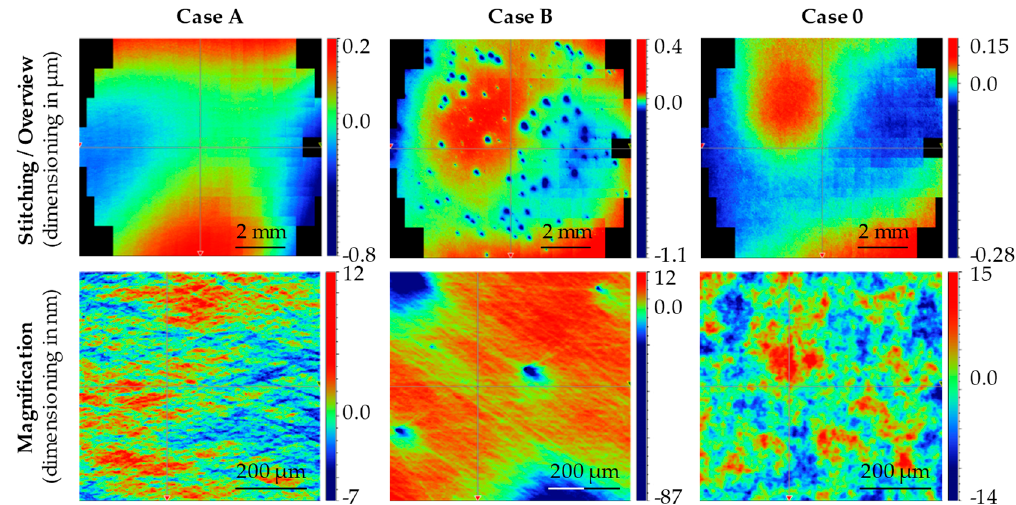
Figure 10. WLI (White Light Interferometry) stitching and in-depth measurements for different surface topologies on Glassy Carbon according to the proposed case studies.